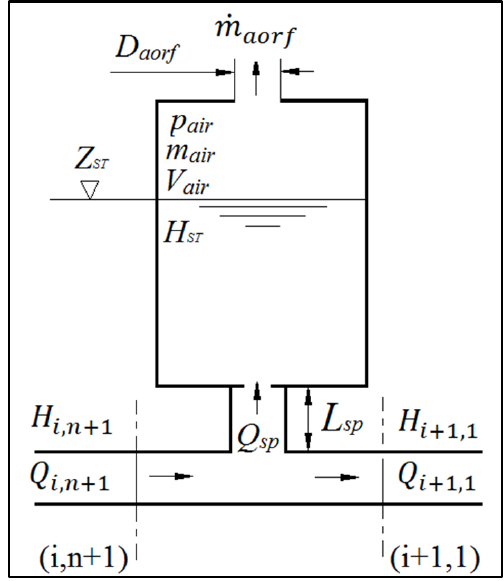
Figure 1. Cylindrical semi-pneumatic surge tank scheme.